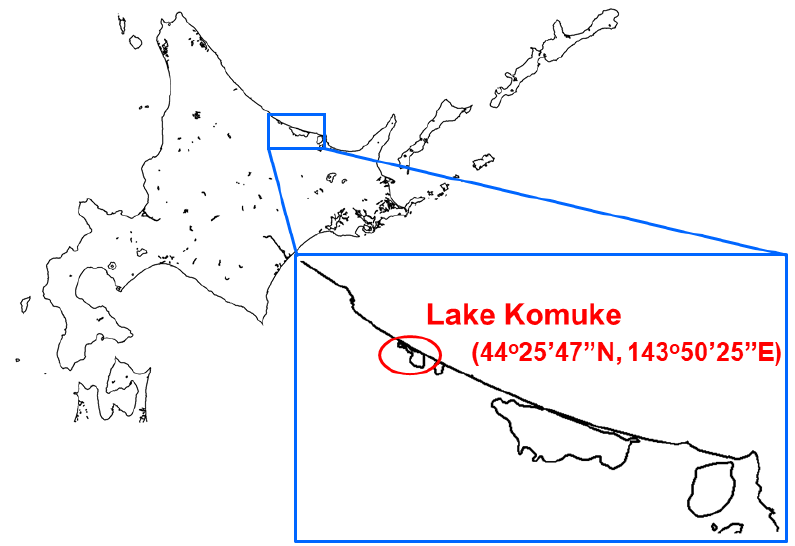
Figure 1. Location of a fecal sample collection. Fecal samples were collected at Lake Komuke, northeastern Hokkaido, in Japan in October 2020.